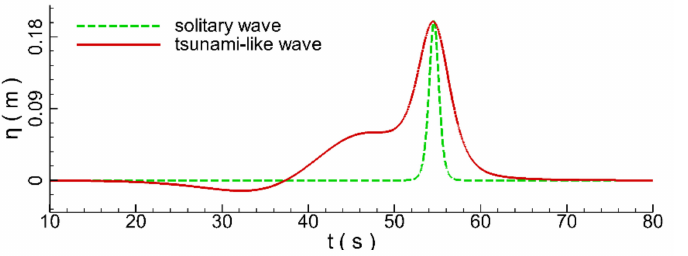
Figure 2. Comparison of the time series of the wave profiles of the solitary wave and the tsunami-like wave with h = 1 m and H = 0.2